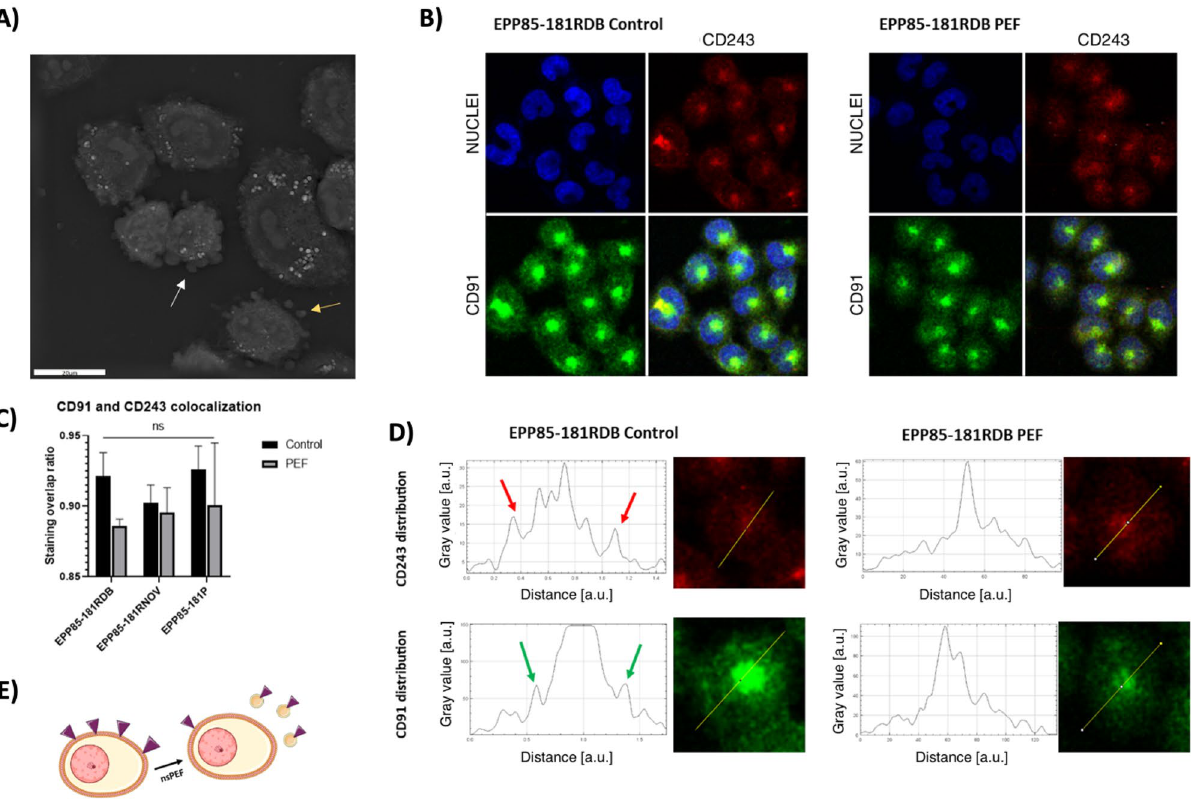
Figure 4. ( A ) Holotomographic microscopy photograph showing EPP85-181RDB cells 13 min after nsPEF treatment. White arrow indicates micro vesicles (MV’s) being detached from the cell membrane and yellow arrow shows already freely detached MV’s from the membrane; ( B ) the immunofluorescence staining of CD91 (green) and CD243 (red) 24 h following the exposure to nsPEF treatment of EPP85-181RDB cells; ( C